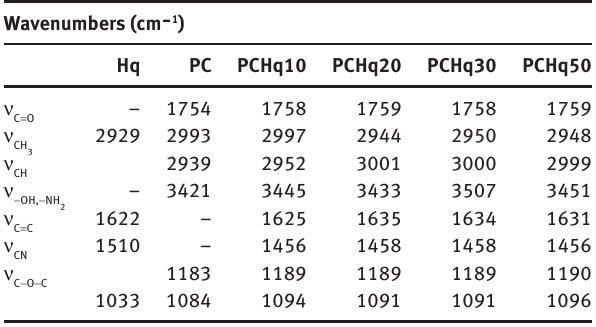
Table 2: Differential scanning calorimetric data of poly(lactic acid) (PLA), chitosan (CS), and PCHq nanoparticles using different Hq